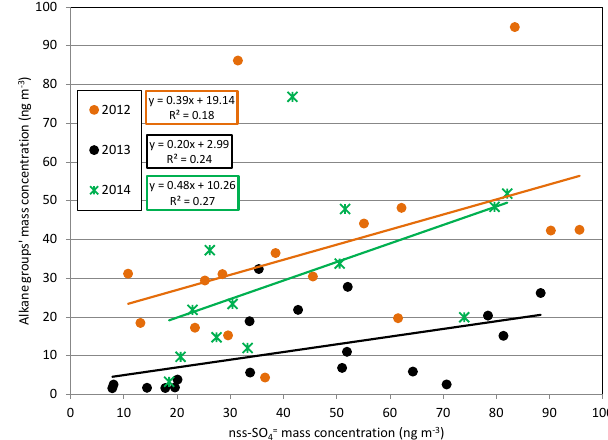
Figure 9. Regressions of mass concentrations of alkane functional groups with nss-SO = for the cleaner weeks during each of the 4 years 2012, 2013 and 2014 (2012: p <0.1; 2013: p <0.04; 2014: p